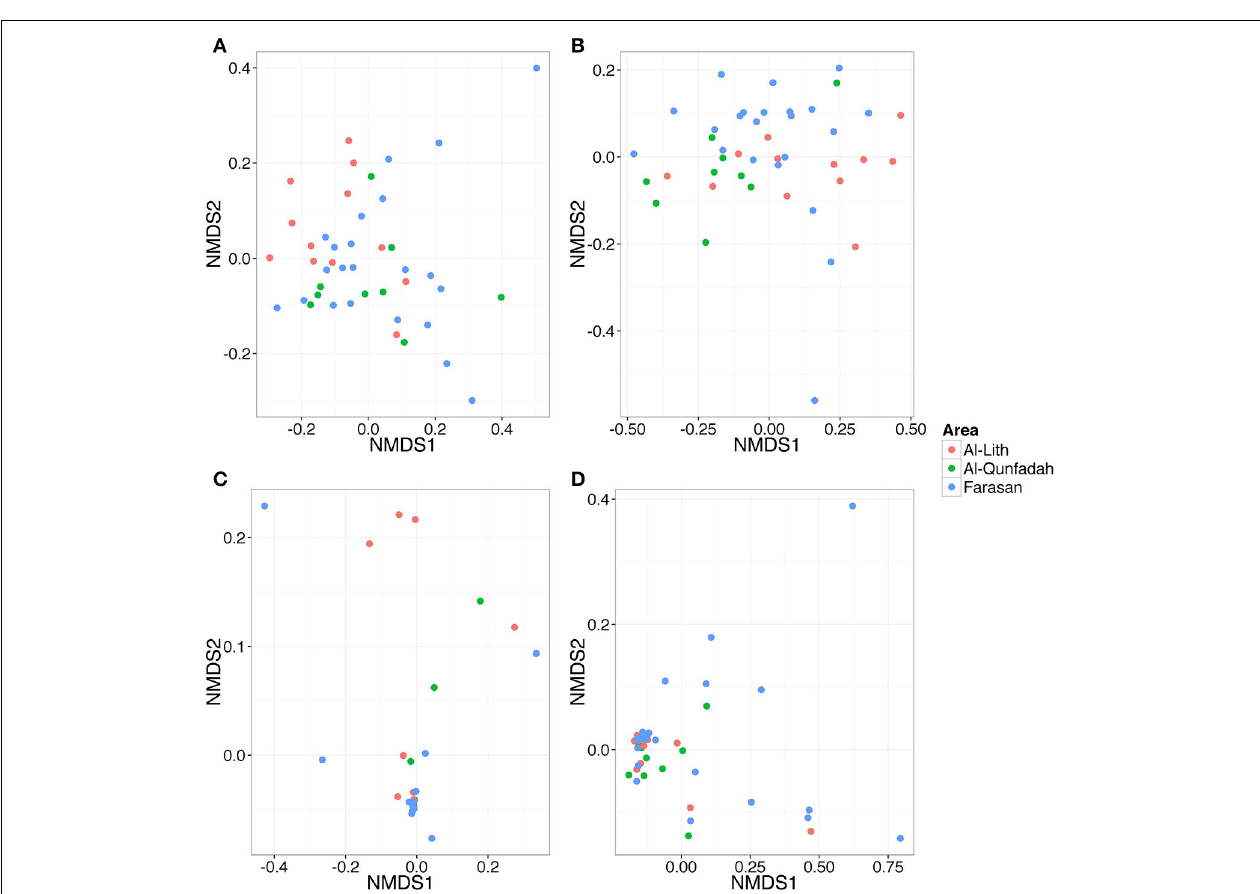
FIGURE 7 | NMDS plot based on weighted UniFrac distance matrices for (A) Metazoa (B) Arthropoda (C) Cnidaria, and (D) Chordata.